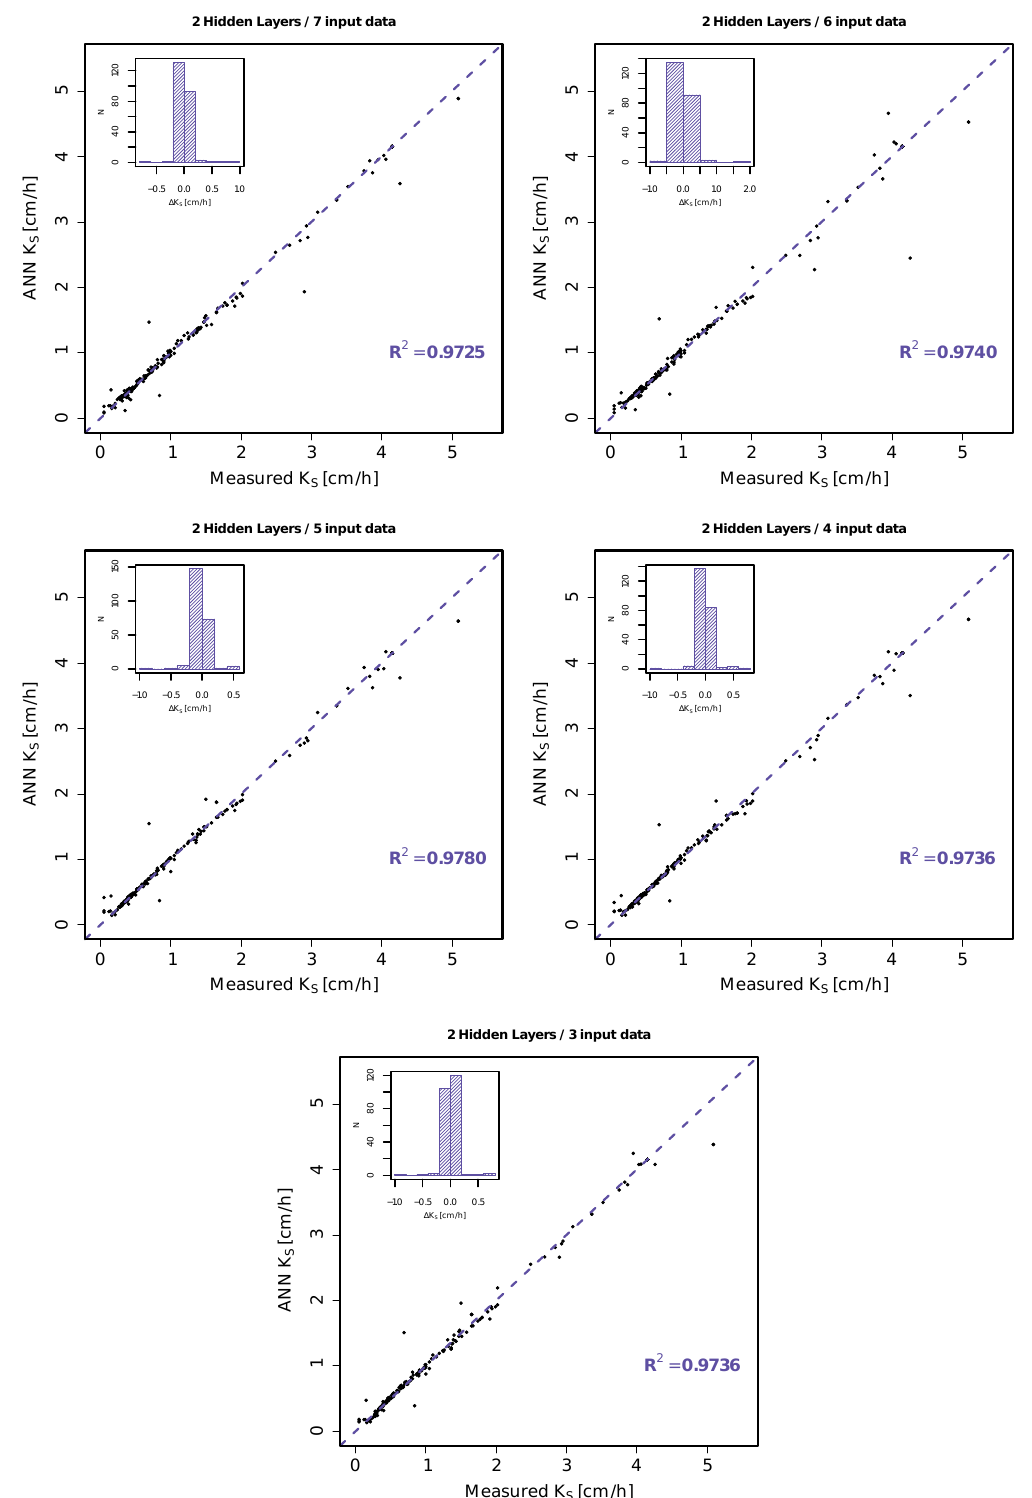
Figure 7. Plots for the comparison between K S measurement in the field with the K S value obtained applying the different ANN configurations. The dotted line is a 1:1 desirable relation. The histograms represent the residual distribution ( ∆ K S